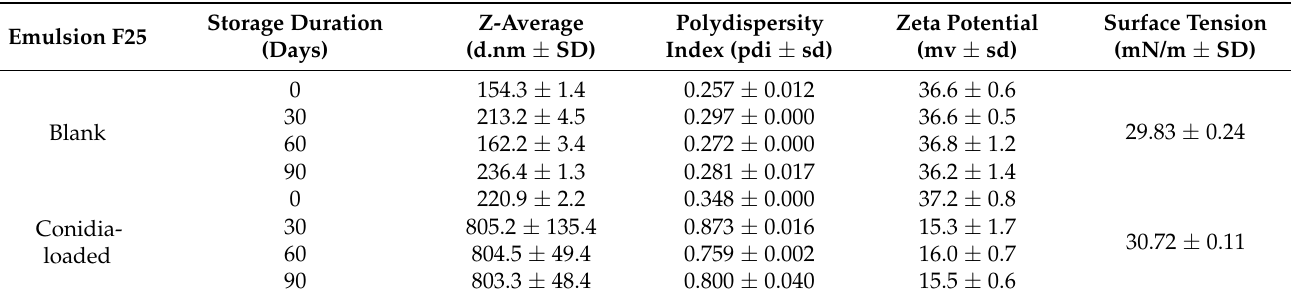
Table 2. Effect of storage duration on the characteristics of emulsion F25 at room temperature. Data expressed as mean ± standard deviation ( n =